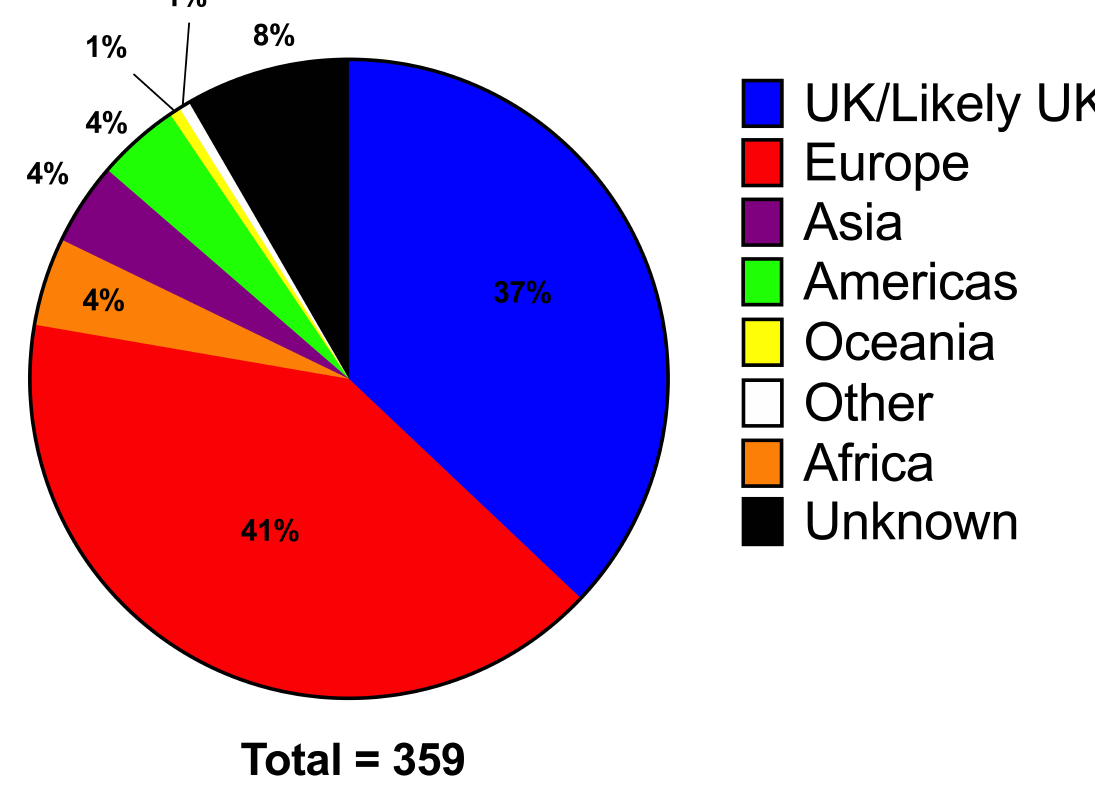
Figure 5. Geographical location of sunburn injury in combined adult and paediatric patients between 2010–2019 (inclusive). n = 359 (288 adults, 131